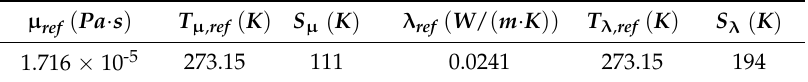
Table 2. Sutherland’s laws